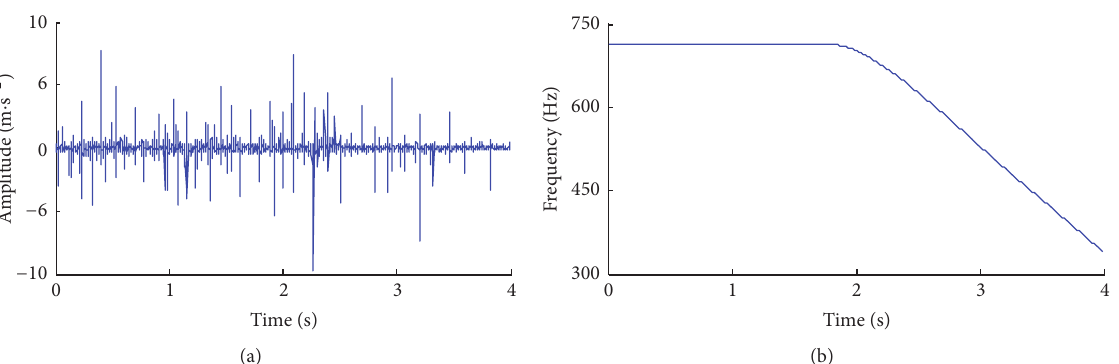
Figure 12: The vibration acceleration signal and the corresponding rotation speed signal of the inner race bearing. (a) The acceleration signal; (b) the rotation speed signal.